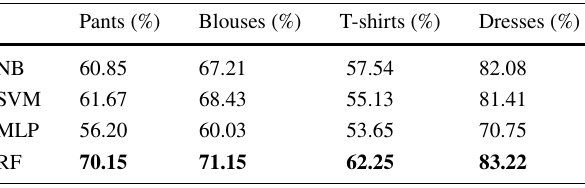
Highest accuracies are shown in Table 4 Root mean squared errors when using different classifiers